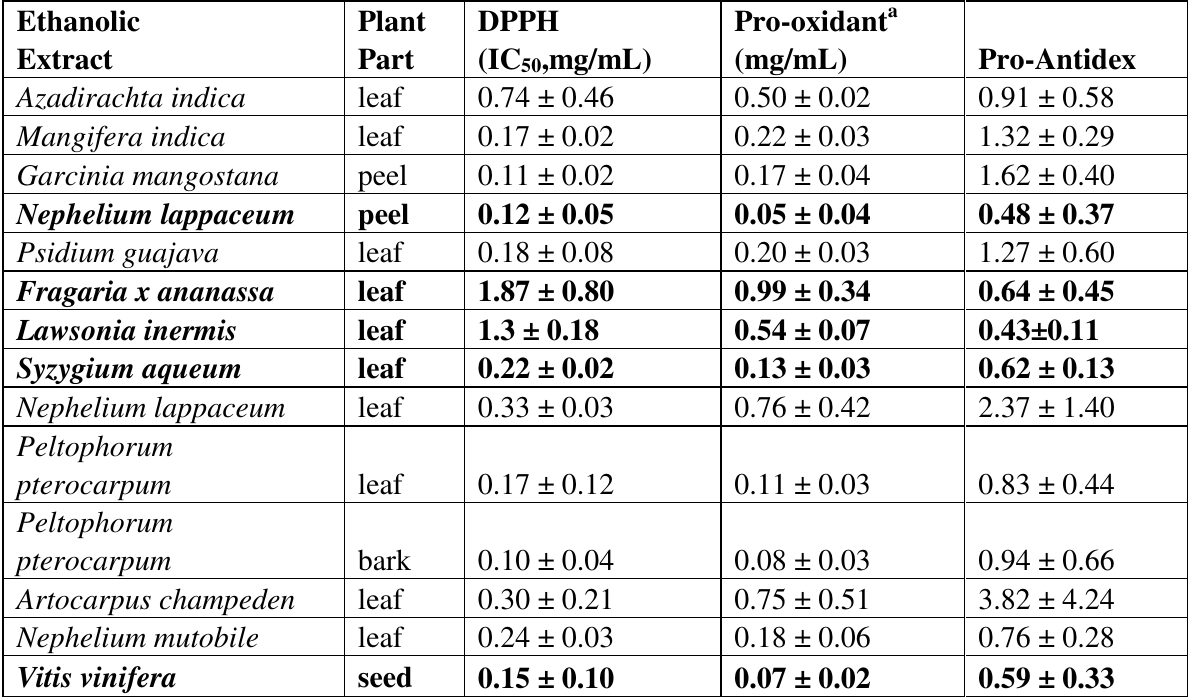
Table 1. DPPH scavenging activity, Pro-oxidant activity and ProAntidex in ethanolic extracts of selected Malaysian plants and standard. ProAntidex was devised using the ratio of pro-oxidant activities to the IC DPPH scavenging activity. All values represent 50 means ± SD, n =